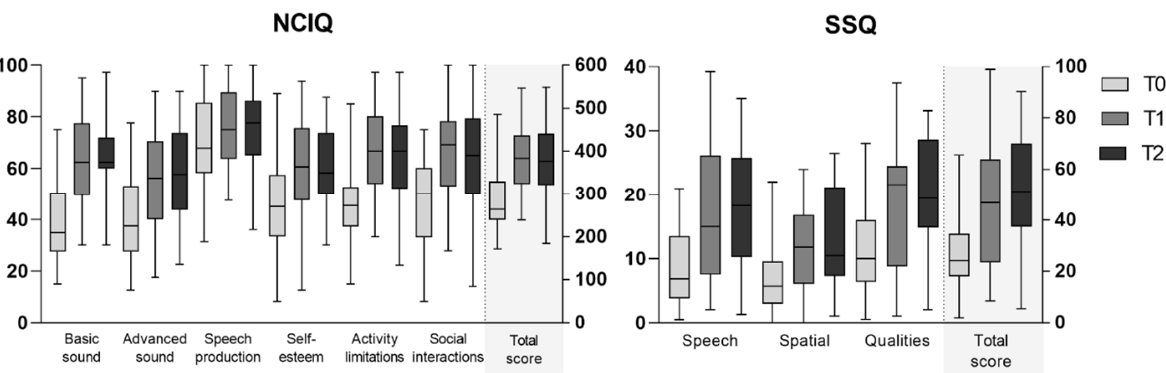
Figure 2. Subdomain percentile scores for the Nijmegen Cochlear Implant Questionnaire (NCIQ) and the Speech, Spatial, and Qualities of Hearing Scale (SSQ) at T0, T1 and T2. Boxes present the median and the 25th and 75th percentiles. Whiskers present the maximum and minimum values. Total scores are presented on the right y axis.